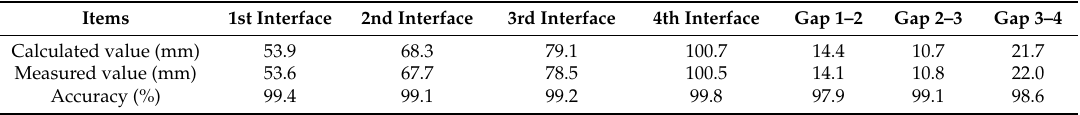
Table 3. Accuracy analysis of four interfaces by